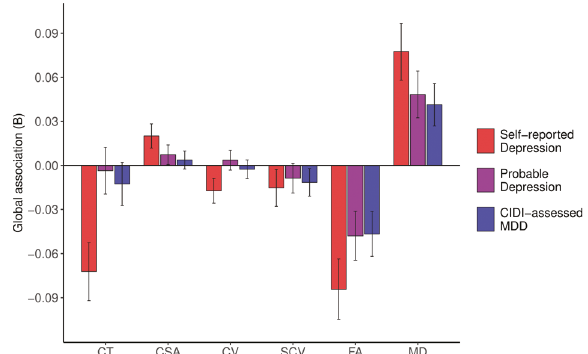
Fig. 1 Associations between lifetime depression phenotypes and global structural brain metrics. Notes . CIDI = Composite Interna- tional Diagnostic Interview (short form); MDD = Major Depressive Disorder; CT = global mean cortical thickness; CSA = total cortical surface area; CV = total cortical volume; SCV = total subcortical volume; FA = global mean fractional anisotropy; MD = global mean diffusivity. Bars represent β coef fi cients for global metric associations with Self-reported Depression (red), Probable Depression (purple) and CIDI-assessed MDD (blue); error bars represent the standard error of the estimated coef fi